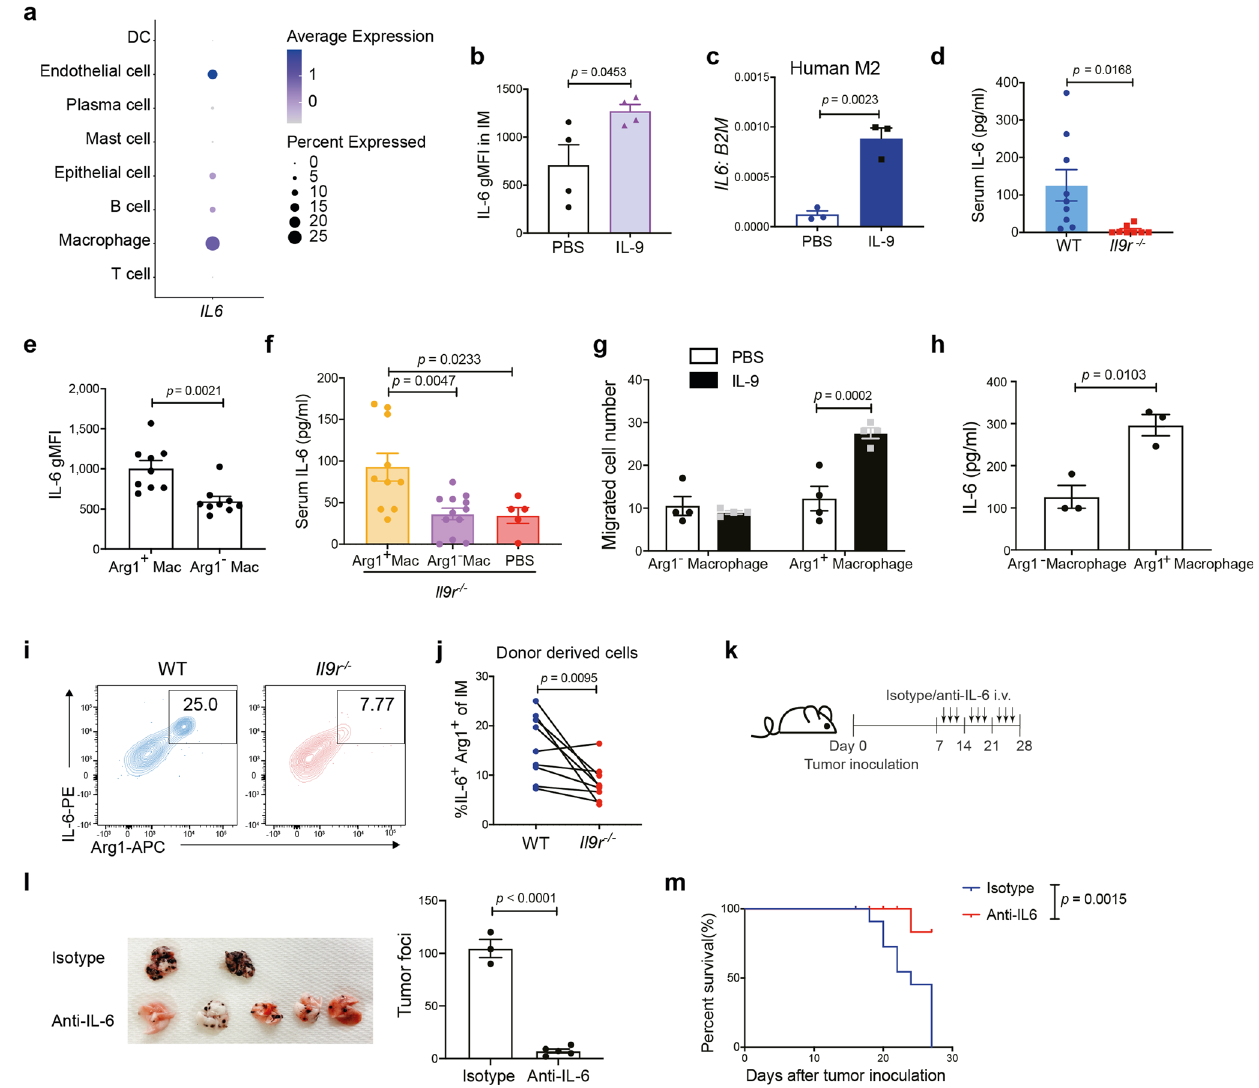
Fig. 8 IL-9 induces IL-6 expression in Arg1 expressing IMs. a Dot plot showing IL6 expression in different clusters from human lung cancer patients scRNA- Seq. b Naive mice were i.v injected with IL-9 for 4 days, IL-6 expression in IMs was analyzed ( n = 4 mice). c IL6 expression in human PBMC monocyte derived M2 macrophage ( n = 3 donors). d Serum IL-6 level in B16 tumor bearing mice ( n = 9 mice for WT group, n = 8 mice for Il9r − / − mice). e IL-6 expression was analyzed by gating on Arg1 + or Arg1 − macrophages from WT B16 tumor bearing mice ( n = 9 mice). f Serum IL-6 level from mice described in Fig. 6f were analyzed by ELISA ( n = 10 mice for Arg1 + Mac group, n = 12 mice for Arg1 − Mac group, n = 5 mice for PBS group). g Arg1 + or Arg1 - macrophages were sorted from entire lung of tumor bearing mice and plated in the lower chamber of the transwell; B16 tumor cells were placed in the upper chamber. Cells were allowed to migrate for 12h ( n = 4 mice). h Arg1 + or Arg1 − macrophages were sorted from entire lung of tumor bearing mice and cultured for 24h, IL-6 concentration was analyzed ( n = 3 mice). i , j Mixed bone marrow chimeric mice were generated and injected with B16 tumor as described. Donor derived IL- 6 + Arg1 + IMs were analyzed by fl ow cytometry, dot plots were gated on live IMs ( n = 9 mice). k – m WT tumor-bearing mice were treated with isotype antibody or anti-IL-6 antibody as shown in k, tumor growth ( l ) ( n = 3 mice for isotype group, n = 5 mice for anti-IL-6 group) and survival ( m ) ( n = 12 mice) were analyzed. Unpaired two-tailed Student t -test was used for comparison in b , c , d , e , h and l . Data are the mean±SEM. One-way ANOVA with a Dunnett ’ s multiple comparison test was used for multiple comparisons in f . Paired two-tailed Student t -test was used for comparison in j . Two-way ANOVA with Sidak ’ s multiple comparisons was used for comparisons in g of non-essential amino acids (Stock; 100 X), 5 mM HEPES (all from LONZA) and for 10 min, permeabilized with menthol for 1 min, stained with Crystal violet dye 57.2 μ M 2-Mercapoethanol (Sigma-Aldrich). for 15min, and quanti fi ed by microscopy. Tumor growth model . Mice were intravenously injected with 0.1 million B16 cells Macrophage induced tumor migration assay . The tumor cell line was starved in or 0.3 million LLCs in 300 µl PBS. Lung tumor growth was analyzed 21 days after FBS-free media for 24h. Total macrophage was isolated from d20 tumor bearing tumor inoculation; mice were euthanized early if weight loss was more than 20% of mice and isolated by using anti-Mertk-biotin antibody (Miltenyi Biotec). 0.2 × 10 6 body weight or if they were visibly distressed. This limit was never exceeded in our macrophage was placed in the lower chamber in complement DMEM media with studies. Mice were euthanized by CO 2 asphyxiation and lungs were washed with or without IL-9 (40ng/ml, Biolegend, 556004). Tumor cells (0.1 × 10 6 ) were placed cold PBS for two times. BALF cells were counted and centrifuged at 1500 g for in the upper chamber in Serum free media. Cells were allowed to migrate for 16h 5 min at 4°C for further surface staining. Lung tumor loci were counted and lung for B16 cells or 3 h for LLC cells. Migrated cells were fi xed with 4% formaldehyde was weighed. A portion of lung tissue was taken for histology analysis. The rest of